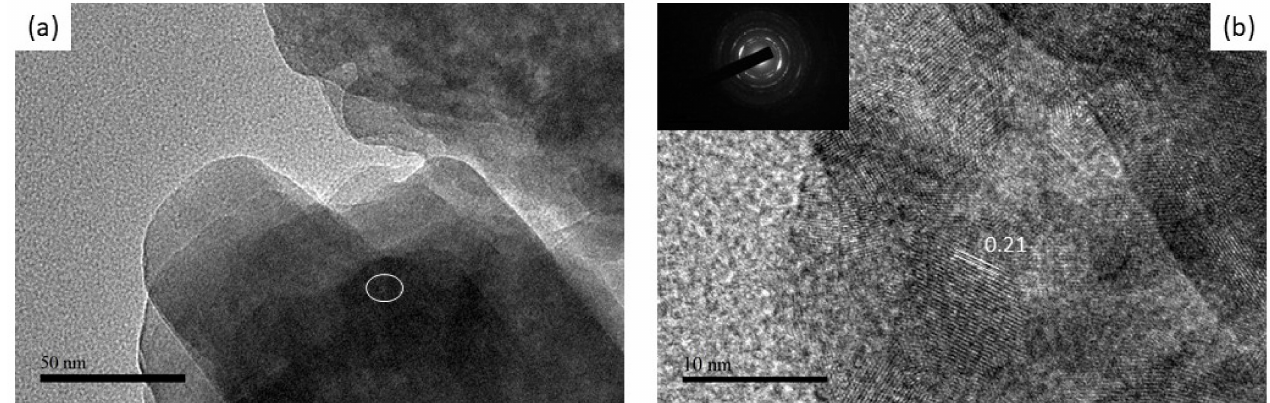
Figure 5. TEM images of ( a ) as-synthesized 10-MCC, and ( b ) and the corresponding HRTEM image with the SAED image in the